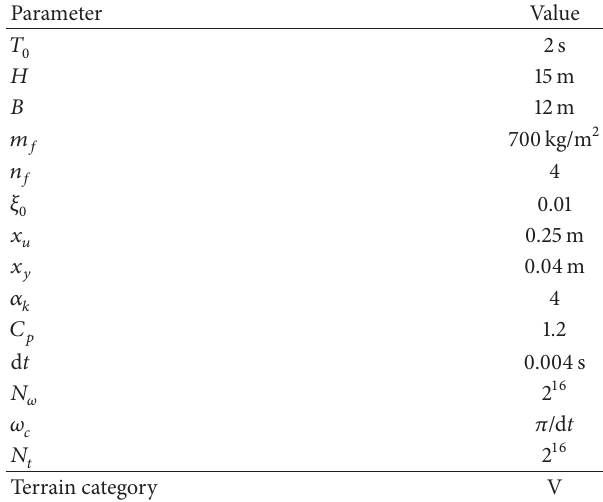
Table 3: Case study and simulation parameters for the first para- metric